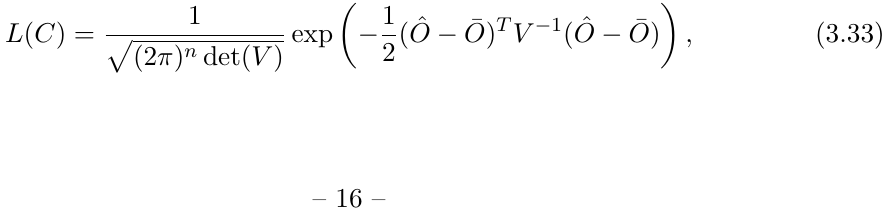
Figure 2 . The left (cid:12)gure shows the relative % level change in each observable shifting from the ^ (cid:11); ^ m Z ; ^ G F to the ^ m W ; ^ m Z ; ^ G F input scheme de(cid:12)ned as ( X m f g f g handed (cid:12)gure shows the total theoretical error in each observable in the handed red bar), the total theoretical error in each observable in the blue bar) and the experimental error (right yellow bar) when quoted in ref. [83]. The numerical results are reported in table